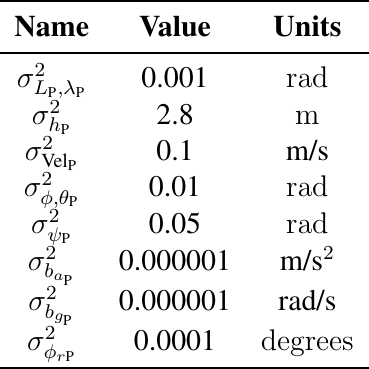
Table 4. Error covariances for P